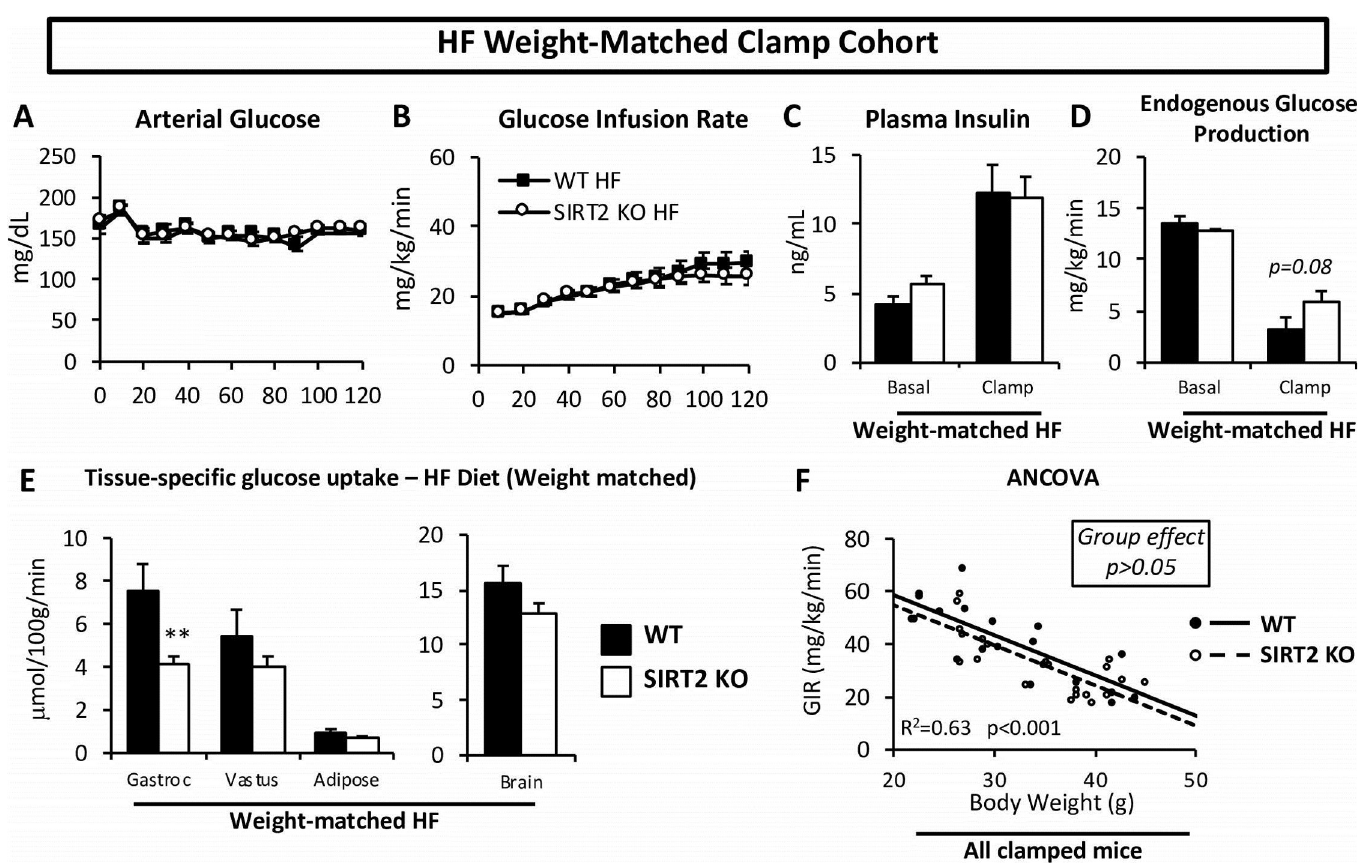
Fig 8. Weight-matched HF WT and SIRT2 KO mice only exhibit increased muscle insulin resistance during the insulin clamp. Mice whose body weights were within 1SD of the average body weight of all HF mice were included (38.4 ± 4.2 grams). Body weights of weight-matched HF subgroup are presented in Table 1. A : Blood glucose was monitored throughout the clamp at 10-min intervals by sampling from the arterial catheter. Blood glucose was maintained at euglycemia ( * 150 mg/dL). B : The GIR in the venous catheter needed to maintain euglycemia in weight-matched HF-fed mice. C : Plasma insulin levels at baseline and during the clamp in weight-matched HF- fed mice. D : endoRa, a marker of hepatic glucose production, in weight-matched HF-fed mice, determined by administration of [3-3H]glucose. E : Rg in gastrocnemius, vastus lateralis, white epidydimal adipose tissue and brain is determined by the administration of nonmetabolizable glucose 2[14C]deoxyglucose in weight-matched HF- fed mice. F : GIR plotted against body weight for all WT and SIRT2 KO clamped mice (chow and HF). The regression lines were generated by the ANCOVA statistical tool. For clamp data of entire HF groups, see Figs 4 and 6 and Table 1 (n = 7-10/group for all panels, see Table 1).